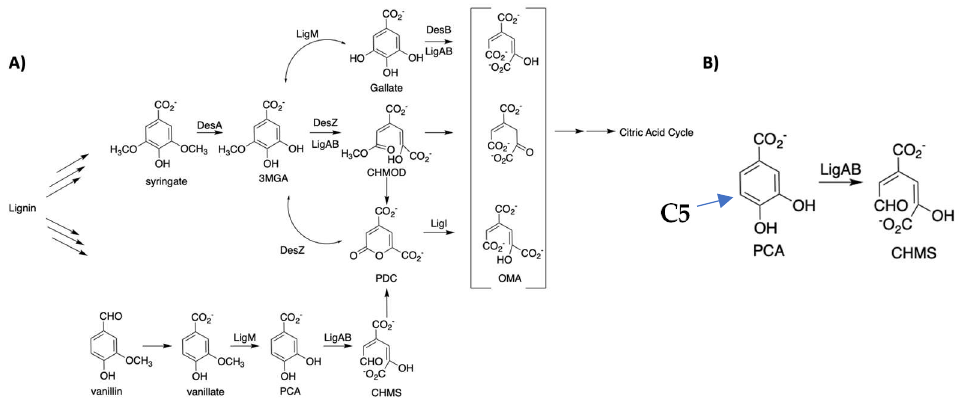
Figure 1. Lignin degradation pathway in which LigAB catalyzes the deoxygenation reaction of various phenolic compounds. ( A ) A portion of the lignin degradation pathway from Sphingomonas paucimobilis sp. strain SYK-6 in which LigAB is found. LigAB catalyzes the ring opening of its endogenous substrate, 4,5-protocatechuic acid, but also other LDACs within and outside of the shown pathway. ( B ) The aromatic ring opening reaction of protocatechuic acid, the native substrate of LigAB. The F103 𝛼 recognizes functional groups on the C5 position (indicated with a blue arrow). The H at the C5 position of PCA can be substituted with hydroxyl and hydroxymethyl groups, to respectively yield gallate and 3MGA.